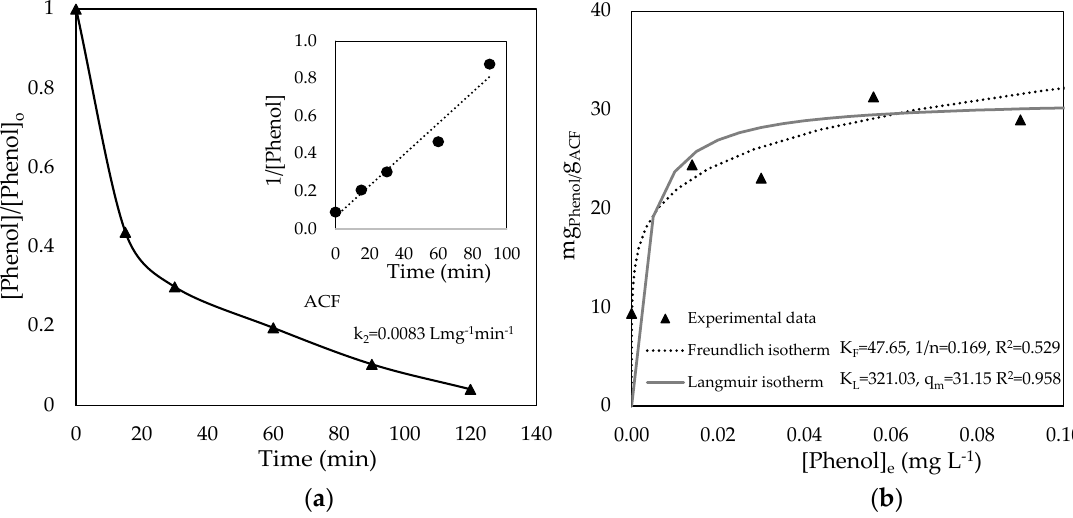
Figure 2. ( a ) Kinetics of phenol adsorption on the unmodified ACF (inset: second-order kinetics graph and respective rate constant), ( b ) non-linear fitting of Freundlich and Langmuir isotherm models for ACF adsorbent.